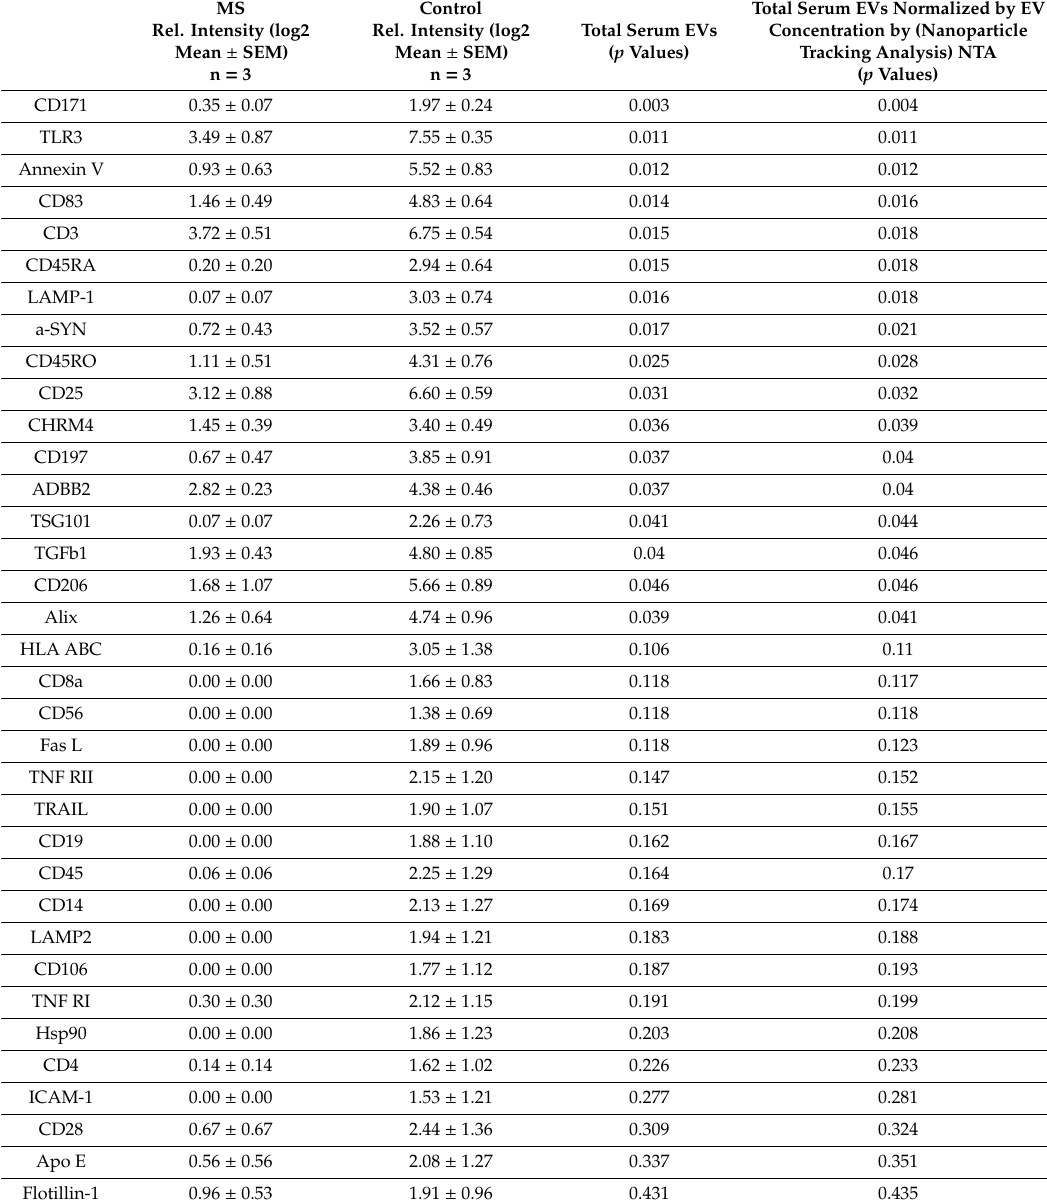
Table 2. Summary of comparisons of extracellular vesicle (EV) array markers between Multiple Sclerosis (MS) patients and